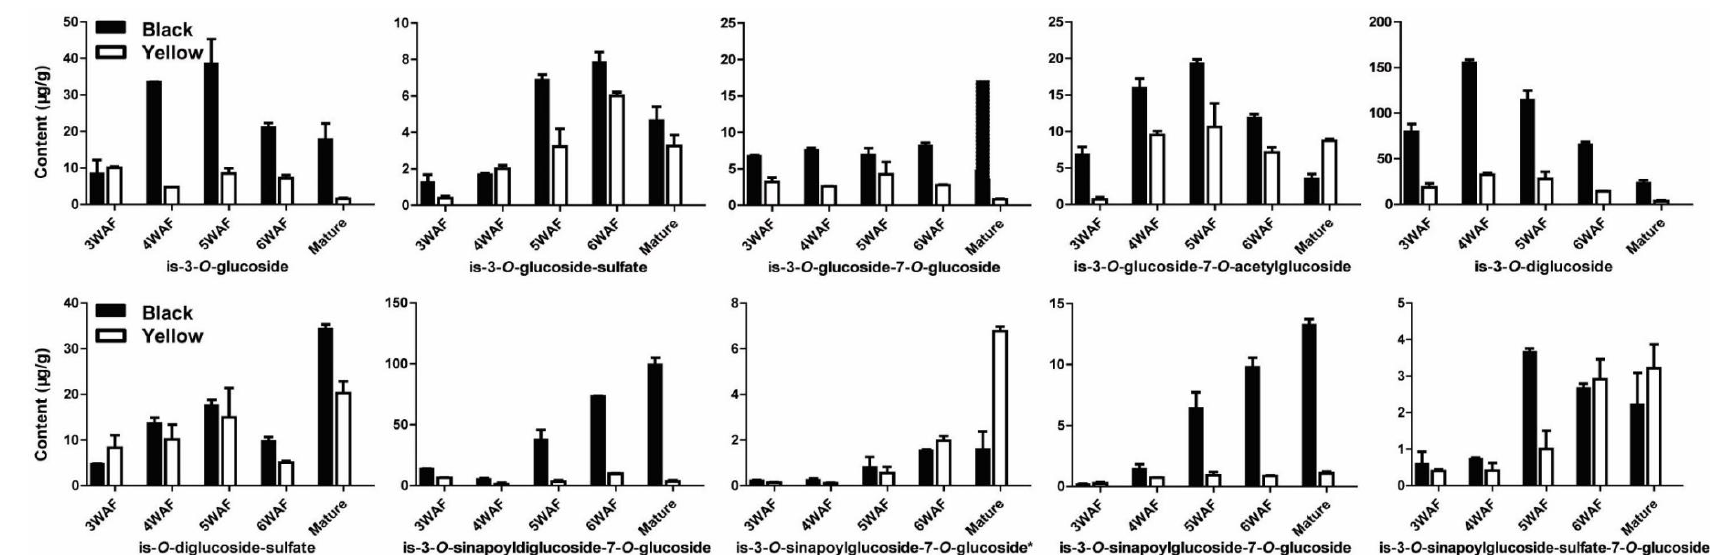
Figure 5. Accumulation pattern of isorhamnetins in yellow and black rapeseed. is, isorhamnetin; WAF, week after flowering.